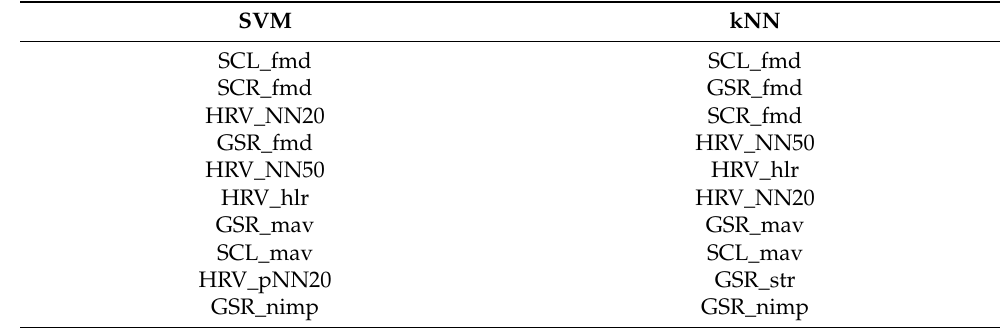
Table 8. Top 10 features selected by the SVM and kNN algorithms for the overlapping dataset.